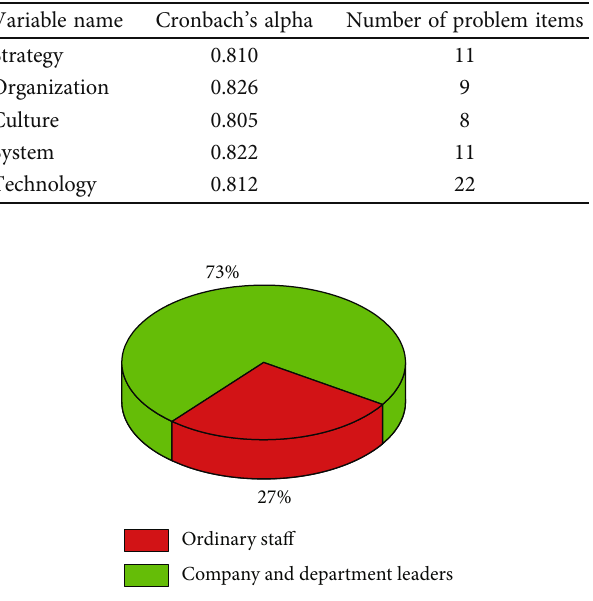
Figure 4: Distribution of survey sample structure by job position.